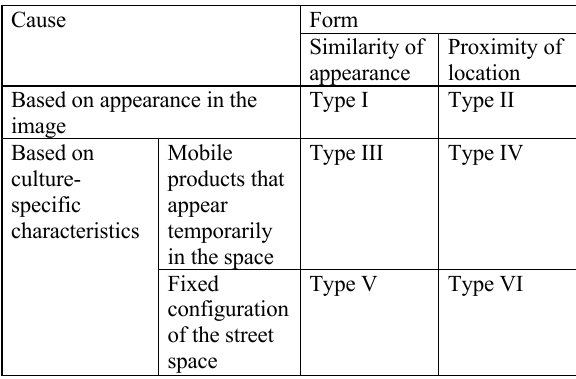
Table 6 . The typology of false inferences.